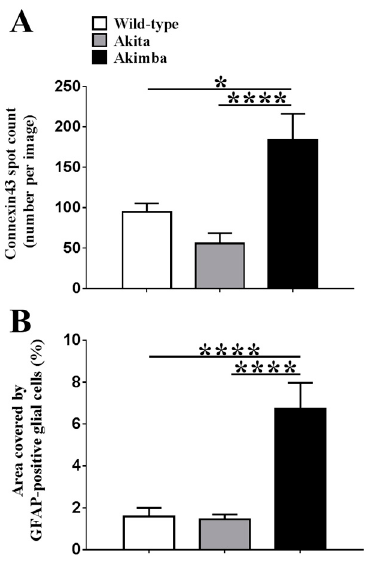
Figure 3. Quantification of ( A ) Connexin43 spots per image and ( B ) % area covered by GFAP labeling in wild-type, Akita, and Akimba retinas. There was no statistically significant difference in connexin43 spot counts between Akita and wild-type mice ( p = 0.3047). However, the connexin43 spot count was higher in Akimba compared to wild-type ( p = 0.0159) and Akita ( p < 0.0001) mice. There was no statistically significant difference in GFAP labeling in Akita compared to wild-type mice ( p = 0.9878). However, GFAP expression was significantly higher in Akimba compared to wild-type and Akita ( p < 0.0001 for both) mice. Data presented as mean + SEM; statistical comparisons were carried out using one-way ANOVA with Tukey’s multiple comparisons test; n = 4 animals/group; * p ≤ 0.05, **** p ≤ 0.0001.